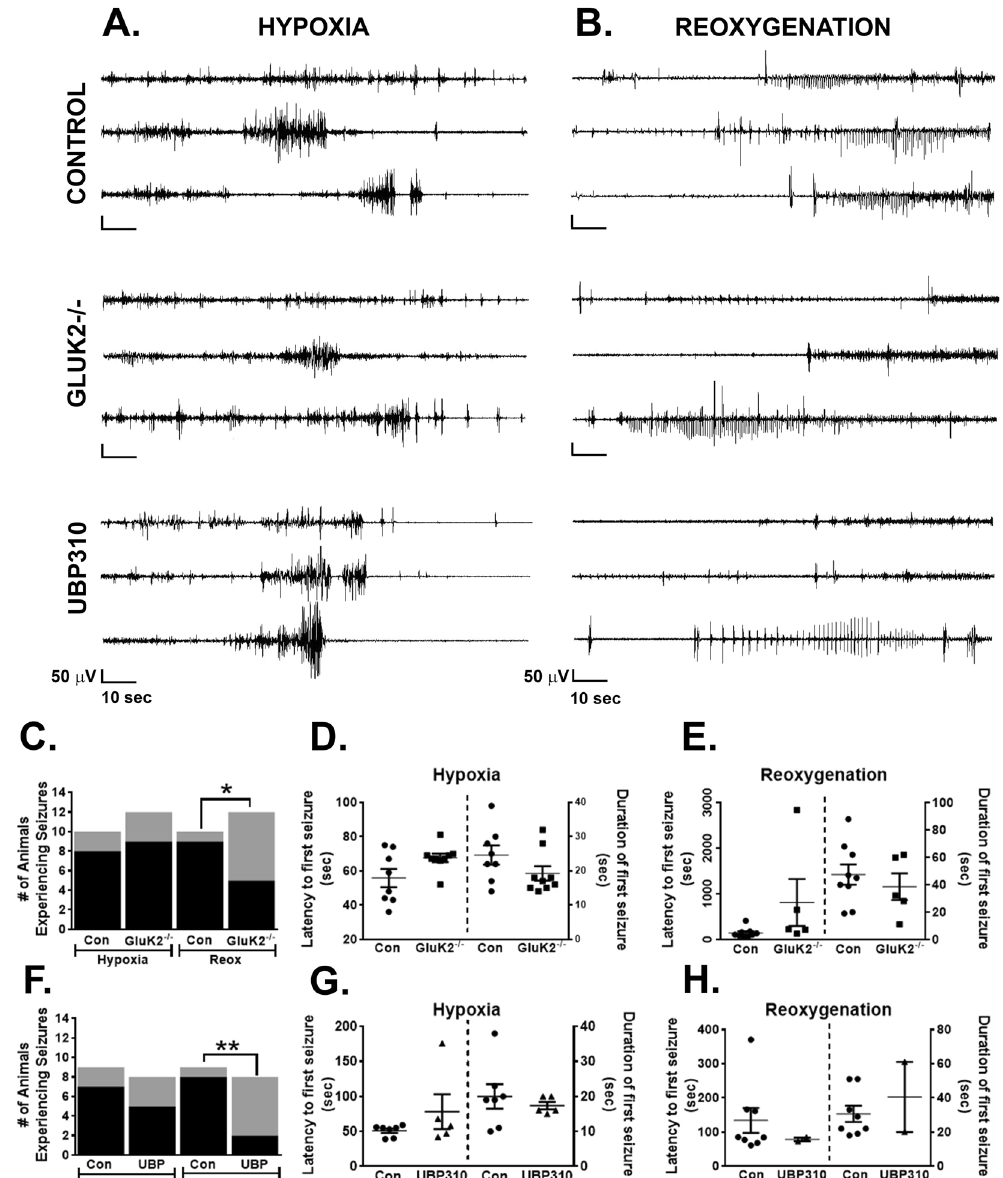
Figure 1. Hypoxia-induced seizures in control, Gluk2 − / − and UBP310-treated neonatal mice. ( A ) Representative hippocampal EEG traces during the hypoxic period in control, GluK2 − / − and UBP310-treated mice. The initial 2 minutes of hypoxia are shown in 3 representative mice for each group, demonstrating seizures in some animals followed by background suppression in all. Of note seizures during this time period are clinically evident with rhythmic head and forelimb clonic jerks. ( B ) Representative hippocampal EEG traces during the reoxygenation period in control, GluK2 − / − and UBP310-treated mice. The initial 2 minutes of reoxygenation are shown in 3 representative mice for each group, demonstrating seizures in some animals. The majority of seizures observed during reoxygenation are electrographic only, emphasizing the need for EEG monitoring in this developmental period. ( C ) Bar graph depicting the occurrence of seizures in control (Con, n = 10) and GluK2 − / − ( n = 12) neonatal mice during hypoxia and reoxygenation ( * p = 0.027, Chi-square; black = seizure, grey = no seizures). ( D , E ) Scatter plots showing seizure latency and seizure duration as mean ± SEM in control and GluK2 − / − mice during hypoxia ( D ). and reoxygenation ( E ). There were no statistical differences in seizure latency or duration between the two groups ( p = 0.054 and 0.138 and p = 0.199 and 0.483 for latency and duration of hypoxic and reoxygenation seizures, respectively, t -test). ( F ) Bar graph depicting the occurrence of seizures in control (Con, n = 9) and UBP310-treated (UBP, n = 8) neonatal mice during hypoxia and reoxygenation ( ** p = 0.0075, Chi- square; black = seizure, grey = no seizures). ( G,H ) Scatter plots showing seizure latency and seizure duration as mean ± SEM in control mice as well as mice pre-treated with UBP310 during hypoxia ( G ) and reoxygenation ( H ). There were no statistical differences in seizure latency or duration between the two groups ( p = 0.222; 0.559 and p = 0.490; 0.465 for latency and duration of hypoxic and reoxygenation seizures, respectively, t -test). ● = control (Con), ■ = GluK2 − / − , ▲ = UBP310-treated, 20